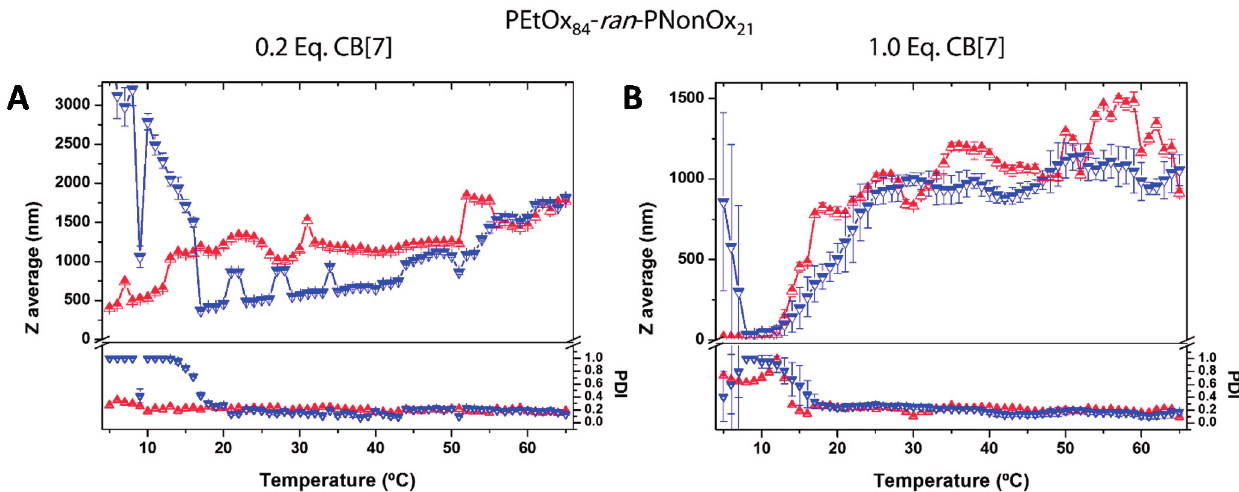
Figure 6. Temperature-dependent Dynamic Light Scattering (DLS) data for a 2 mg·mL − 1 solution of P[(EtOx) 84 - ran -(NonOx) 21 ] in the presence of 0.2 or 1.0 equivalent of CB7 (relative to nonyl side chains). Z average and PDI evolution with temperature: >heating; Ι cooling. ( A ) 0.2 Eq. CB7: At low temperatures, ill-defined aggregates are formed. Upon heating, macromolecular precipitates appear, that partially re-dissolve upon cooling below 20 °C, resulting in an increase in the Z ave ; ( B ) 1.0 Eq. CB7: At low temperature, random coil ensembles ( ≈ 9 nm) coexist with aggregates of sizes from 40 to 300 nm. Beyond 20 °C, large aggregates are formed. Four measurements are averaged at every temperature. Approximate heating/cooling rate: ≈ 0.01 K·min − 1